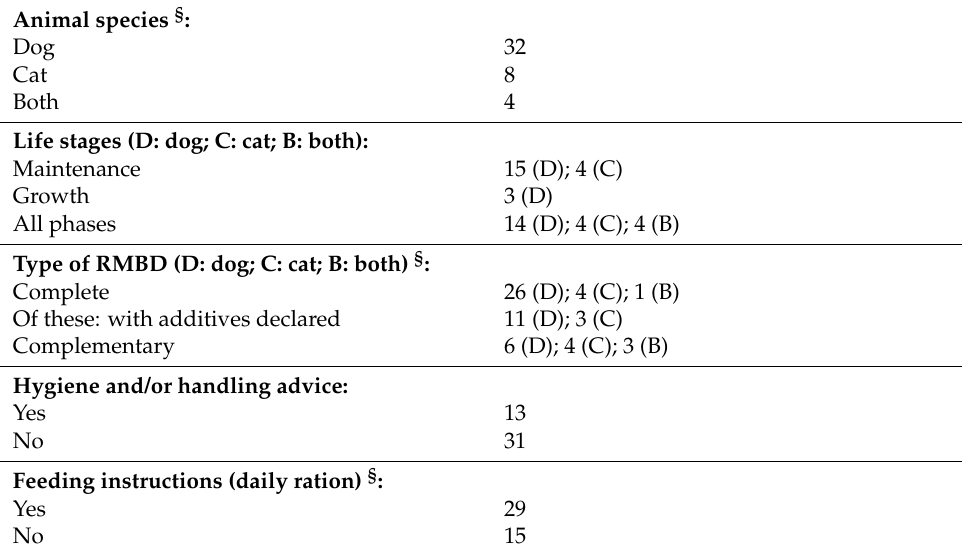
Table 1. Selected labelled information on purchased RMBDs ( n =